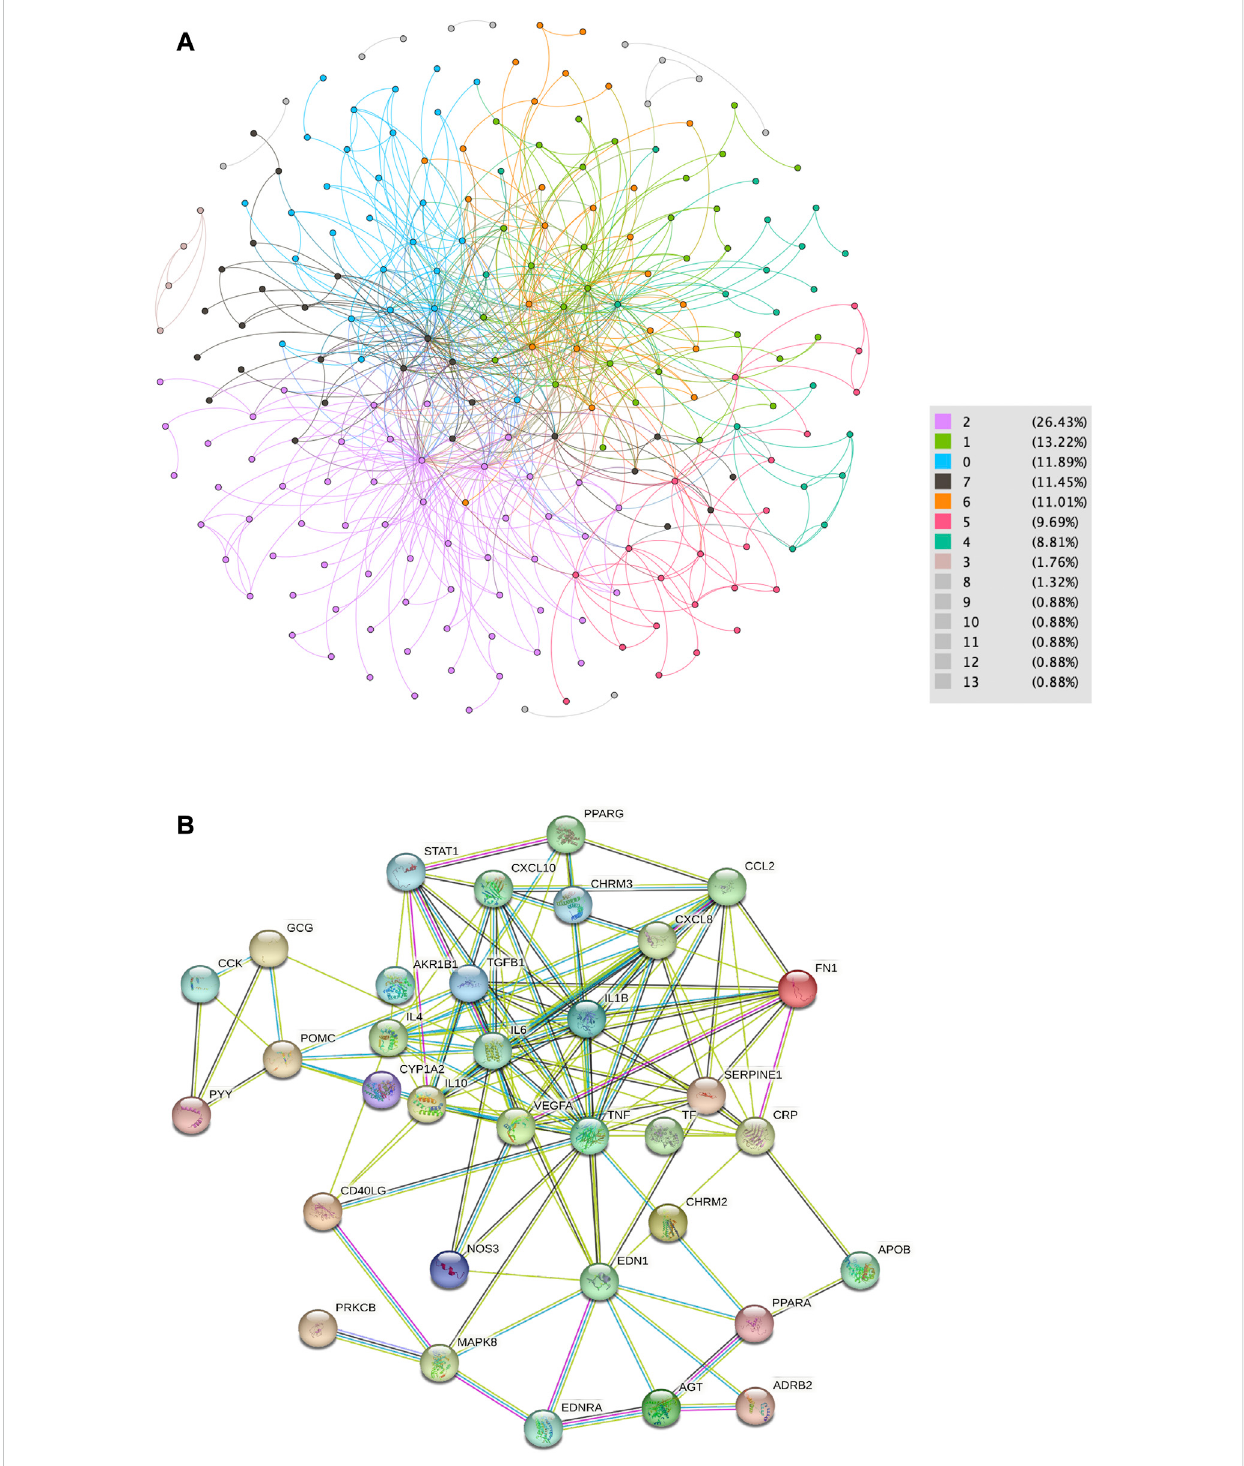
FIGURE 2 Data collation from EMRs. (A) Network map of symptom distribution in patients with HN. (B) Core nodes of the